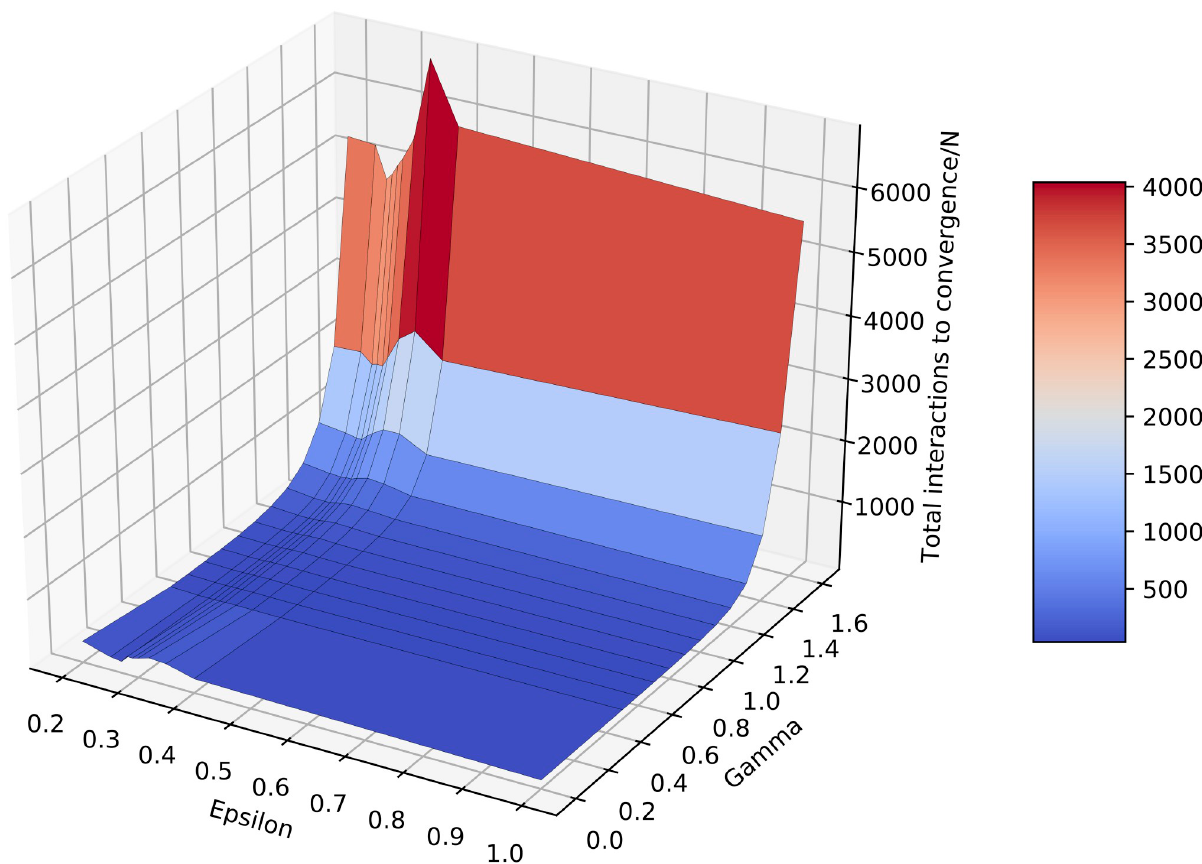
Fig 3. Time to convergence. Total number of interactions required for convergence normalized by the number of individuals, averaged over 100 runs.